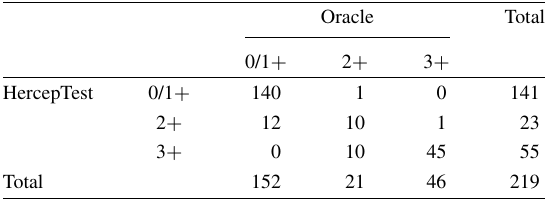
Concordance between the manual polyclonal antibody based Her- cepTest and fully automated monoclonal antibody based Oracle HER2 staining in 219 invasive breast